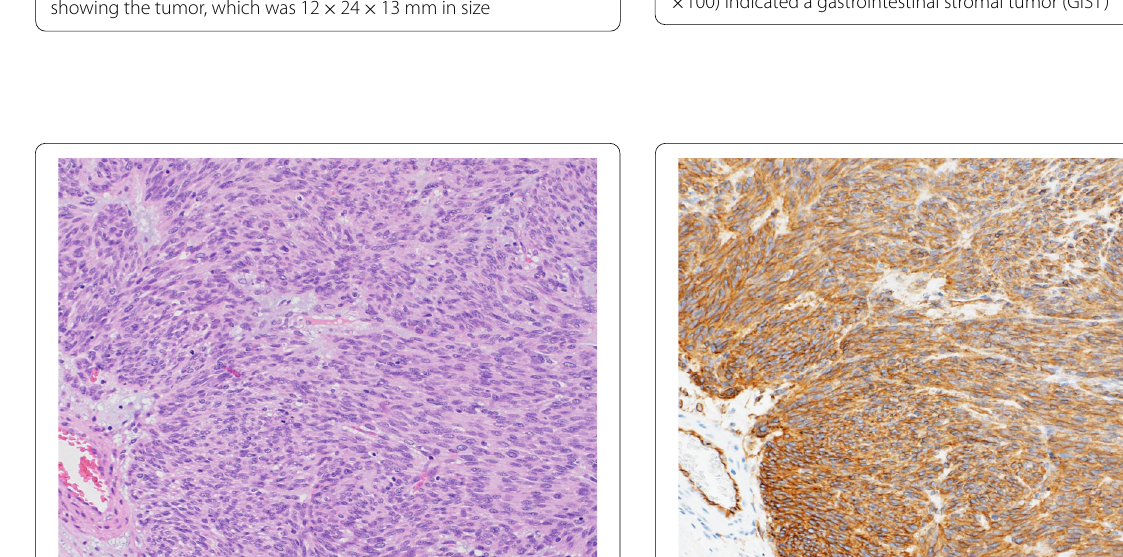
24 13 mm in size × ×